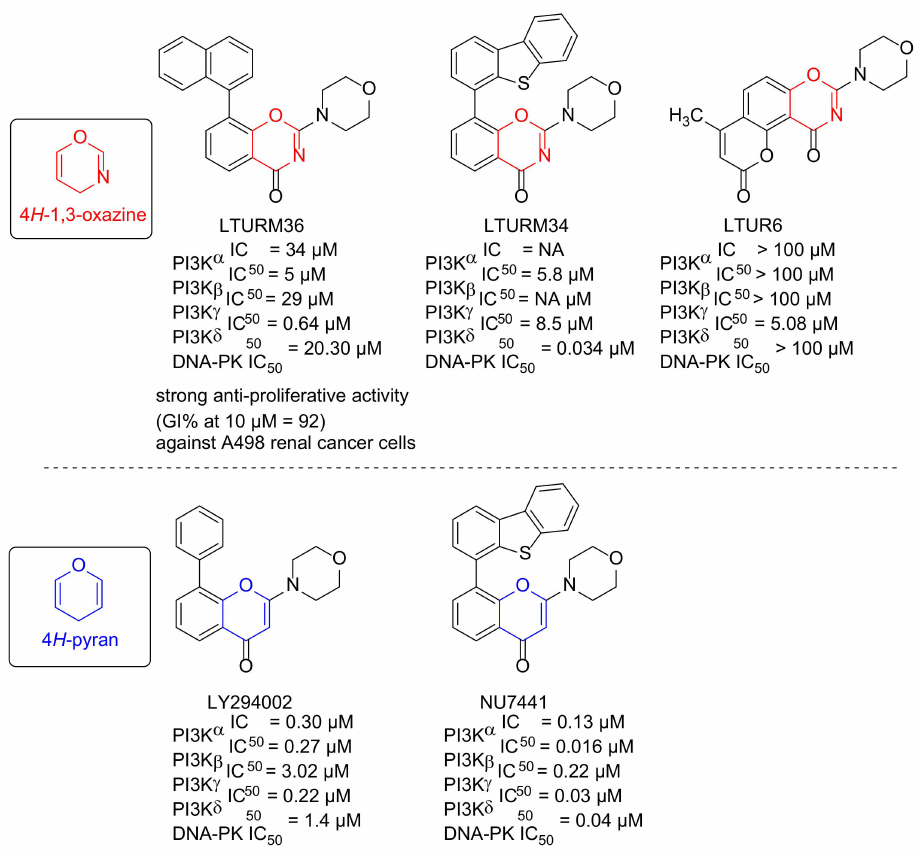
Figure 1. 4 H -1,3-Oxazine based inhibitors and their 4 H -pyran analogs.